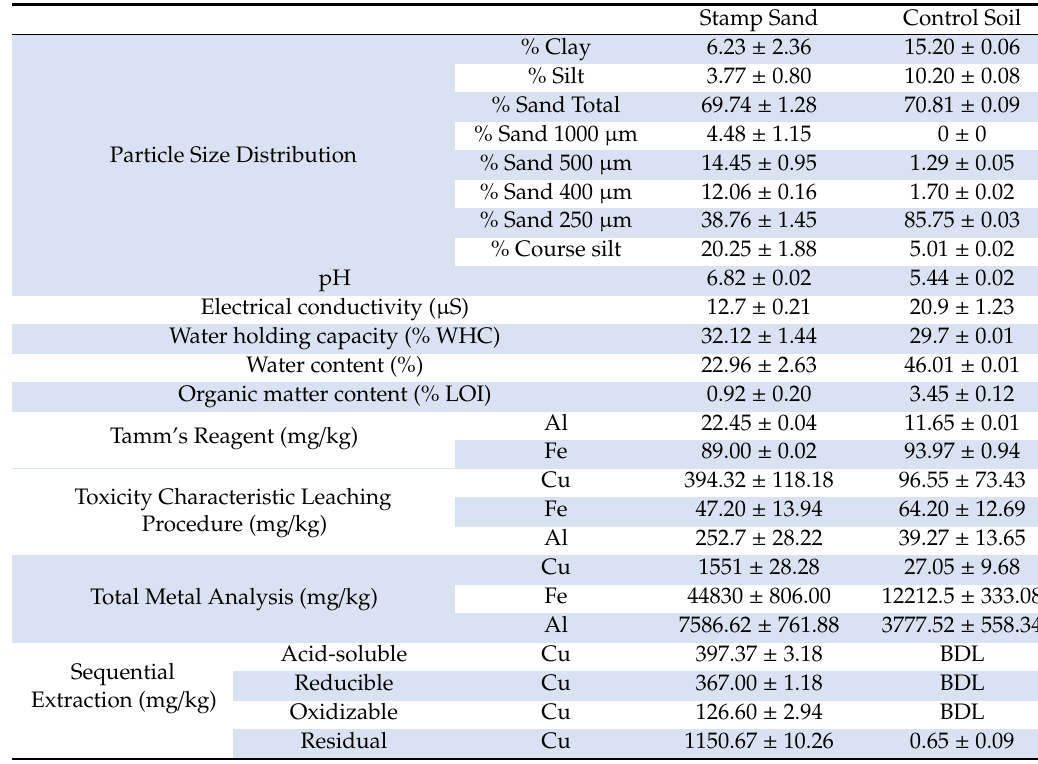
Table 1. The physical and chemical properties of stamp sand and control soil. Shown as averages from triplicates ± standard deviation. Particular to the selection of the control soil was the sand fraction / texture of the soil and the di ff erences in copper concentrations. The % sand fraction of particle size distribution was statistically similar, and the levels of copper were significantly di ff erent between soil types using Welch’s t -test with α =